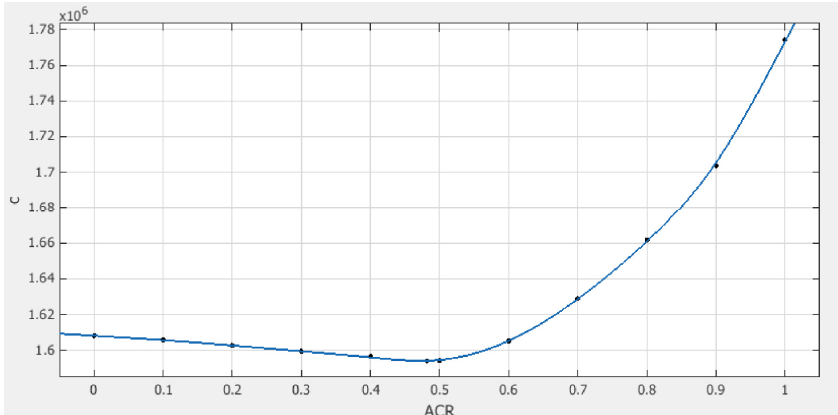
Figure 15. Relationship between ACR and optimal cost.